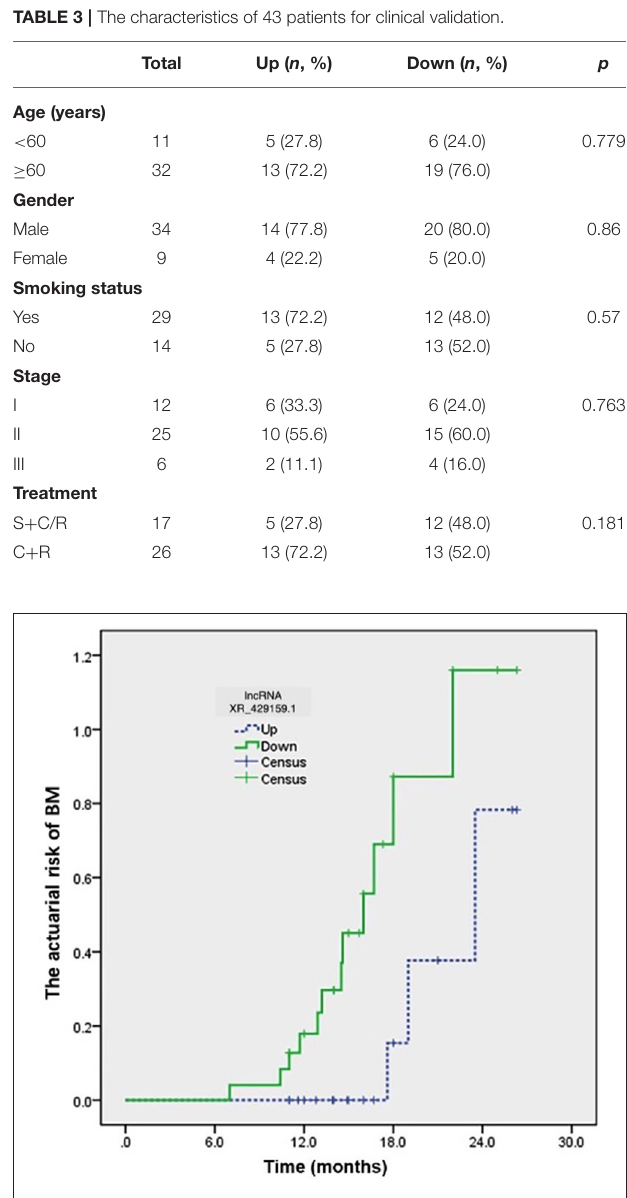
FIGURE 3 | The development time for BM ranged from 7.0 to 26.3 months from the date of diagnosis. The actuarial risk of developing BM at 1 year was 14.3% in patients with high-level lncRNA XR_429159.1 vs. 31.0% in the low-level group. p =